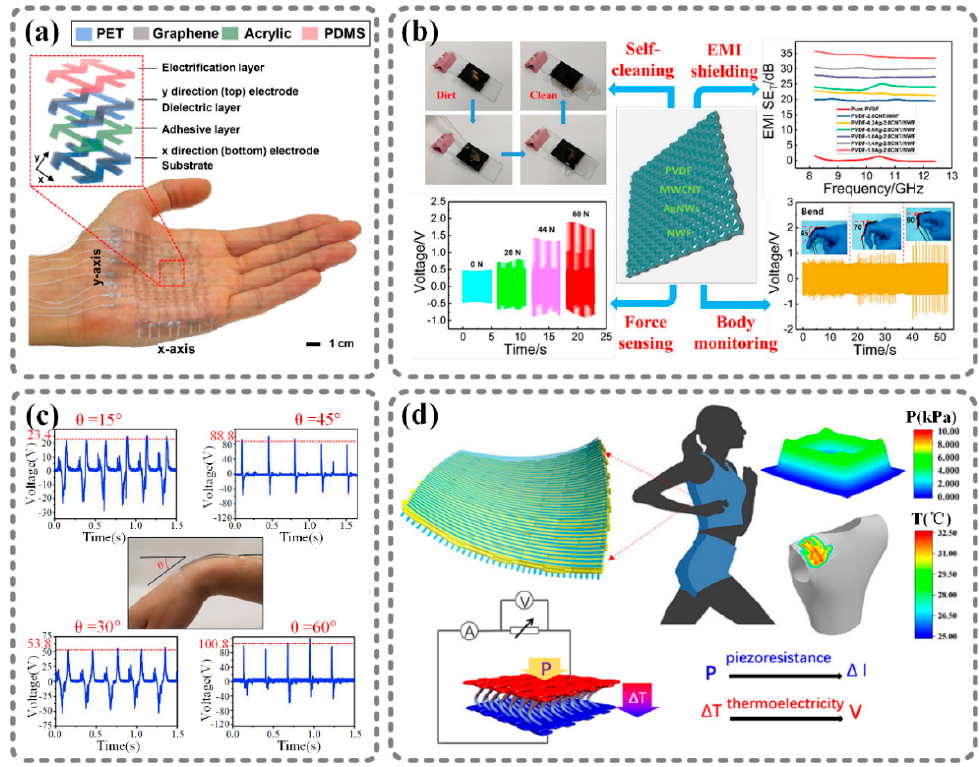
Figure 1. Nanogenerator-based self-powered sensors that directly reflect environmental status. ( a ) Graphene-based stretchable triboelectric nanogenerator (TENG): wearable self-powered touch sensor [44]. ( b ) As-synthesized Ag nanowires and PVDF(polyvinylidene fluoride)-based composite: PVDF-based sensor for force sensing and body monitoring [45]. ( c ) Printed silk-fibroin-based triboelectric nanogenerators: triboelectric nanogenerator (TENG) for angle sensing [46]. ( d ) Poly(3,4-ethylenedioxythiophene):poly(styrene sulfonate) (PEDOT:PSS)-based 3D thermoelectric spacer fabric: self-powered pressure-temperature sensing e-skin [47]. Reproduced with permission from Elsevier [44,46] and American Chemical Society [45,47].